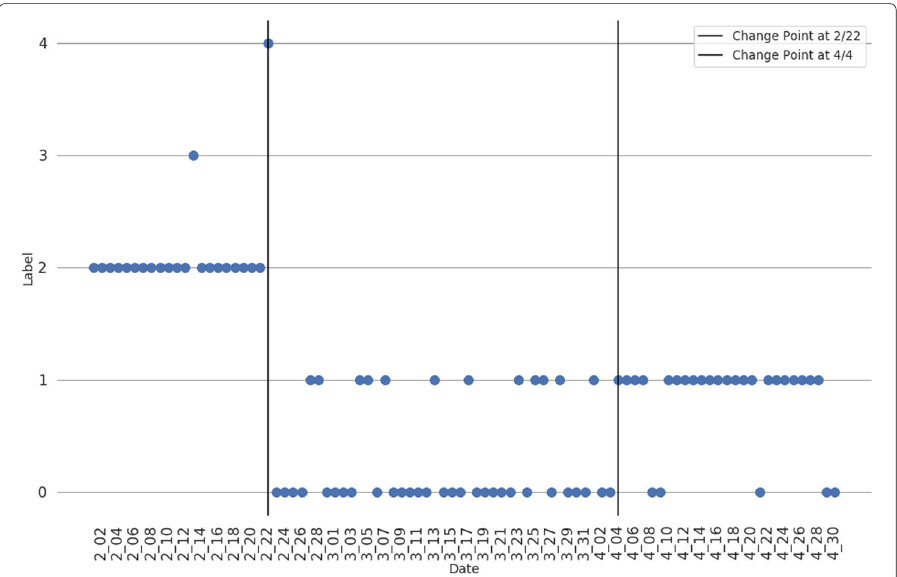
macro, temporal structure to